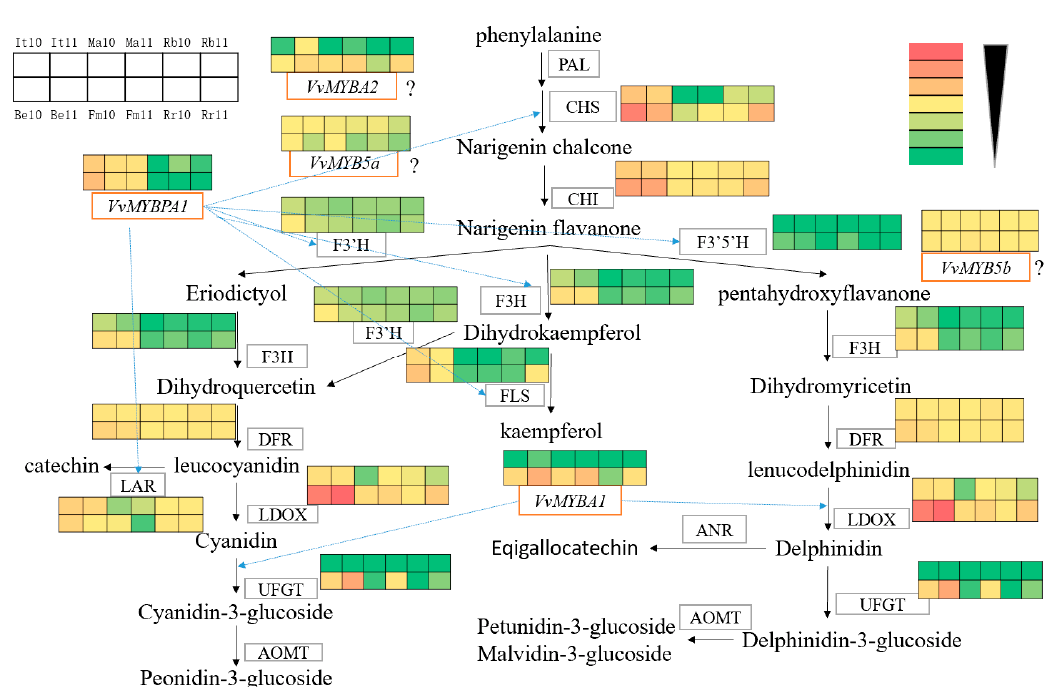
Figure 7. The relationships between the expression color scale of anthocyanin synthesis structural genes and regulatory genes in grape peels and the regulation of the MYBA gene. The blue dotted arrows represent the structural genes in the anthocyanin synthesis pathway regulated by the regulatory gene; the ‘?’ indicates that the regulatory mechanism of the regulatory gene is not yet clear; the green-to-red color scale means the TPM values showed an increasing trend.